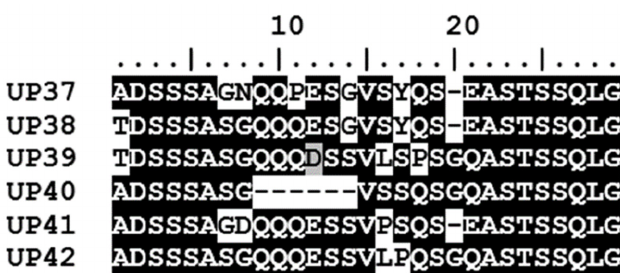
Figure 4. Novel Msp1a repeat sequences detected in this study. Six novel Msp1a repeats (UP37- UP42) were identified in the five calves located in the peri-urban area of the Mnisi community, Mpumalanga. Msp1a sequences were aligned using BioEdit. Conserved amino acid residues in the alignment are highlighted by white text on a black background, while variable residues are shown by black text on a white background.